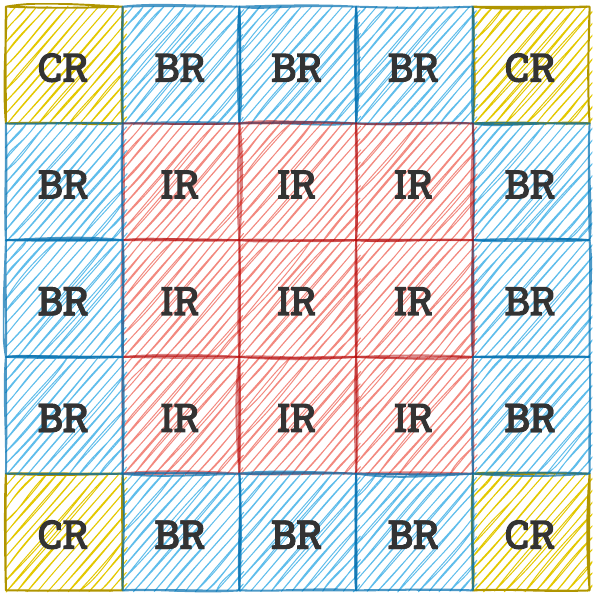
Figure 3. Example of division of an input image into blocks, corner regions (CR), border regions (BR), and inner regions